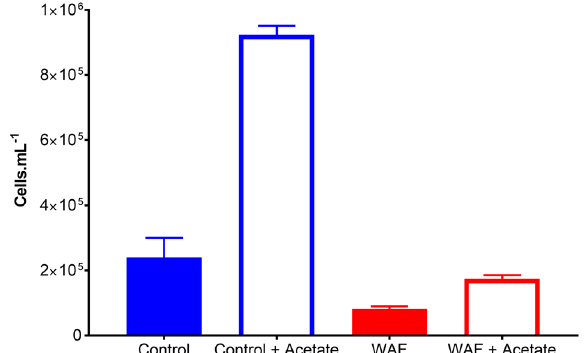
Figure 7. Effect of external organic carbon source (0.5 g.L −1 ) on the growth of T. pseudonana (± standard deviation) after 48 h of incubation under Control and WAF treatments (n = 3).